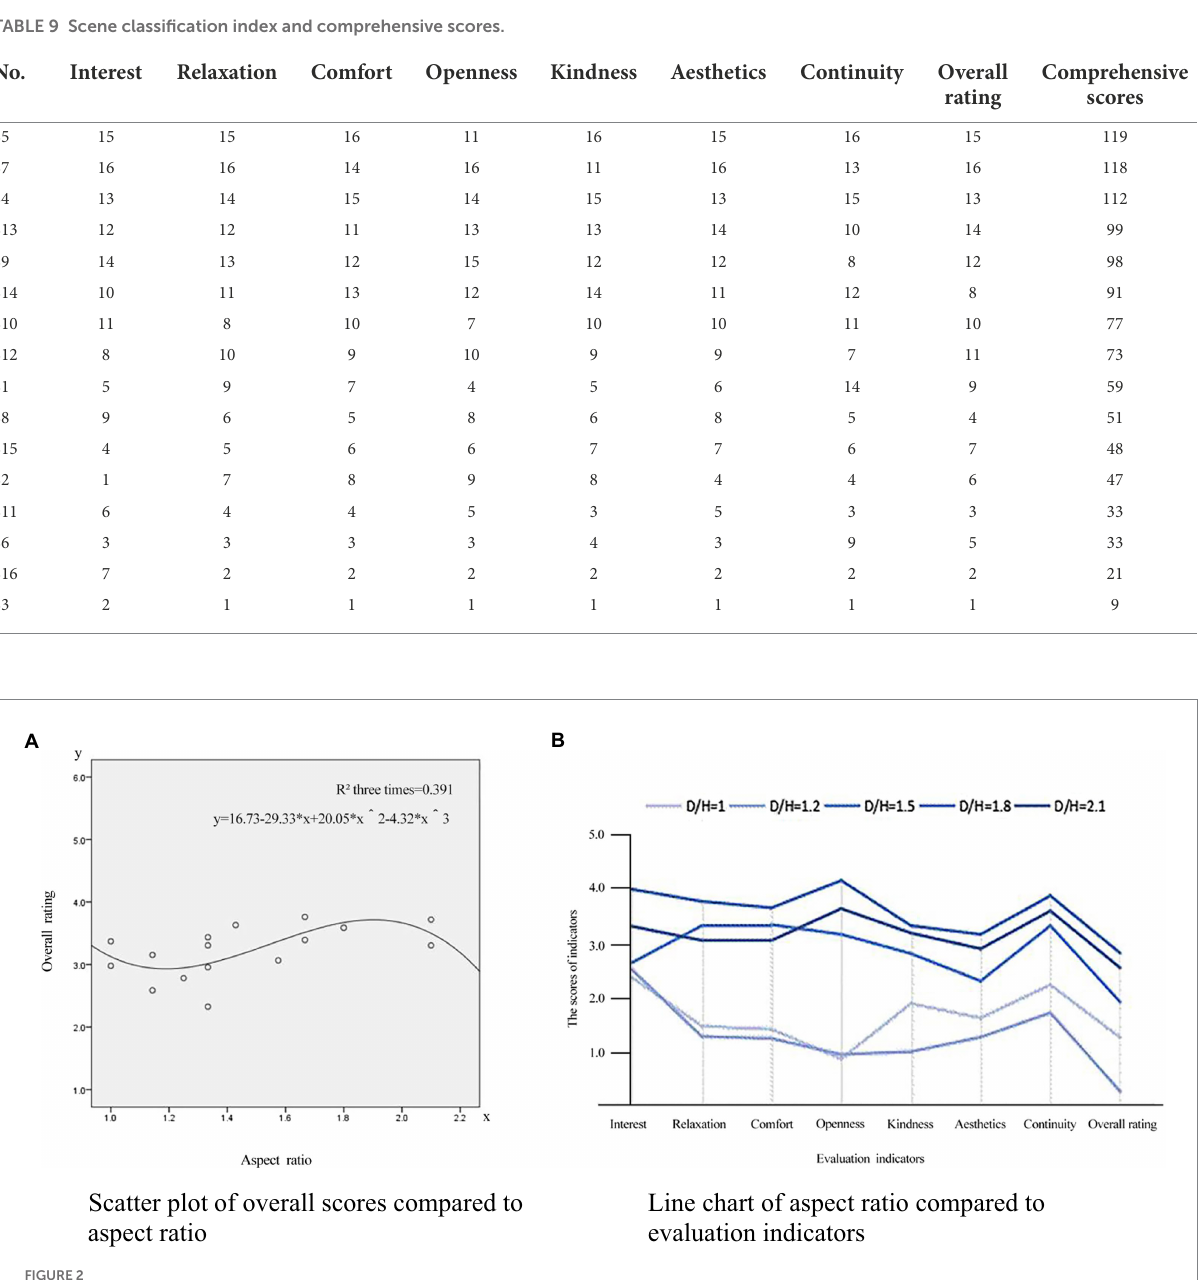
Figure 3B line chart’s corner angle comparison to each evaluation indicator, when the corner angle of the scene is 120 ° , the scores of indicators (except for spatial continuity) and the overall rating are higher than that at the scene with a corner angle of 150 ° . This shows that the corner angle of underground commercial streets is closely related to the users’ cognitive evaluation, and the spatial experience is best when the corner angle is obtuse. However, when the corner angle is >150 ° , the spatial experience becomes less pleasant.